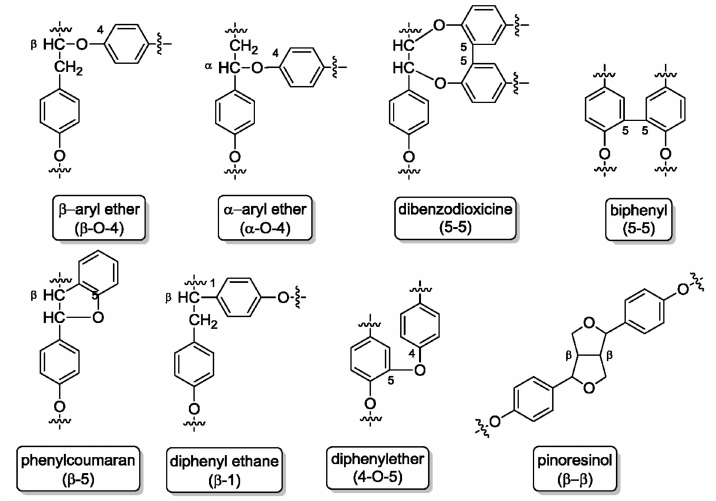
Figure 4. Lignin linkages: ether bonds, carbon-carbon bonds, and further